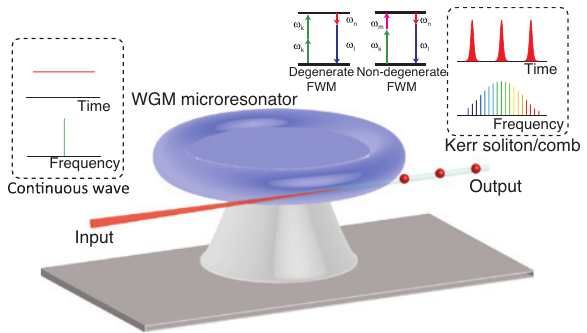
Figure 1: Schematic of Kerr optical frequency comb generation in a WGM microresonator with a tapered fiber